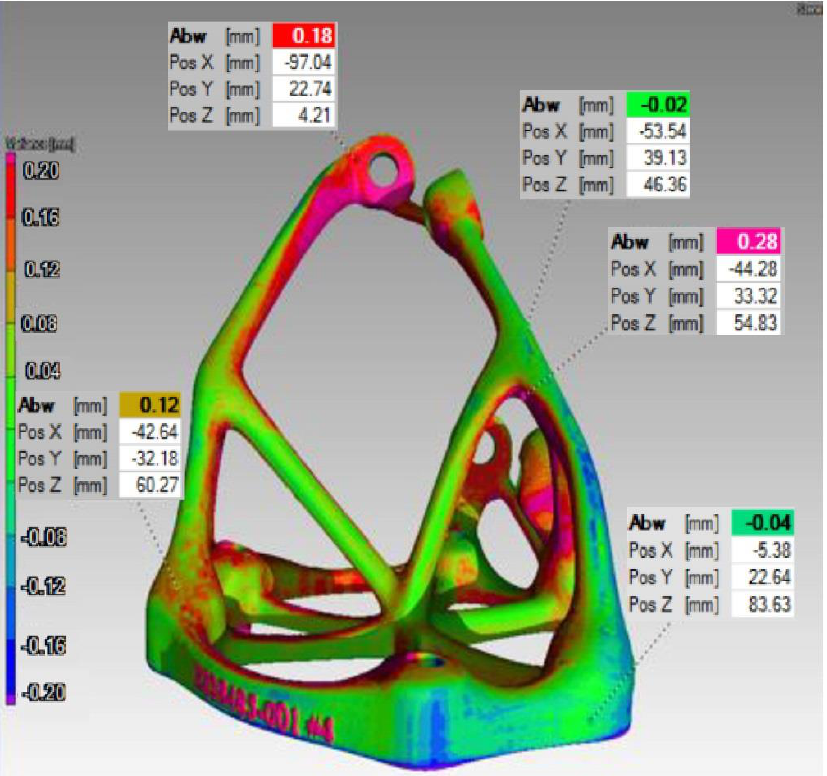
Figure 12. Overlay of nominal CAD geometry with fabricated part geometry obtained from CT scan data.